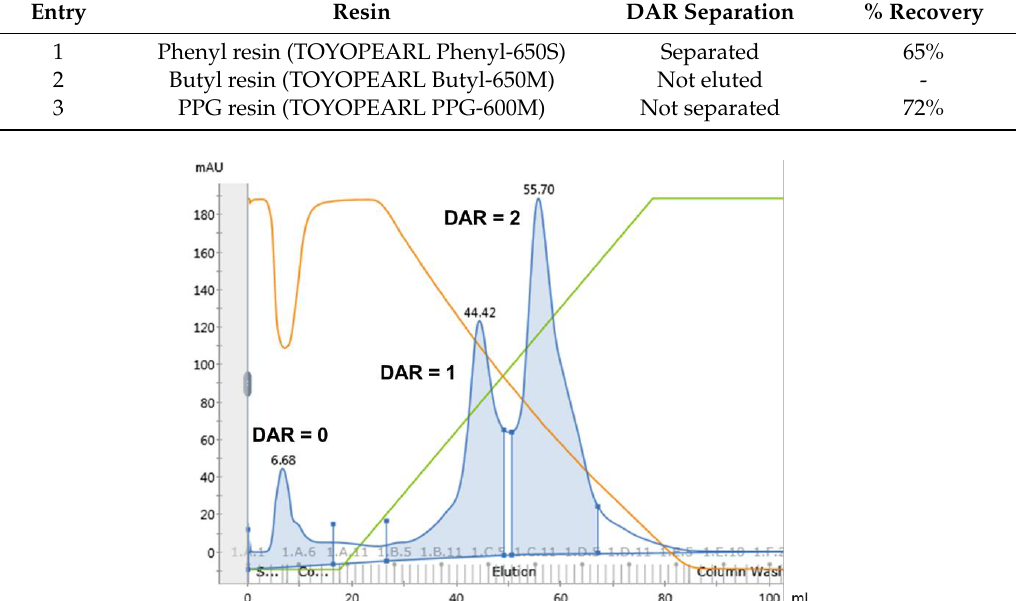
area: UV_280 nm; green line: concentration of mobile phase B; orange line: conductivity.